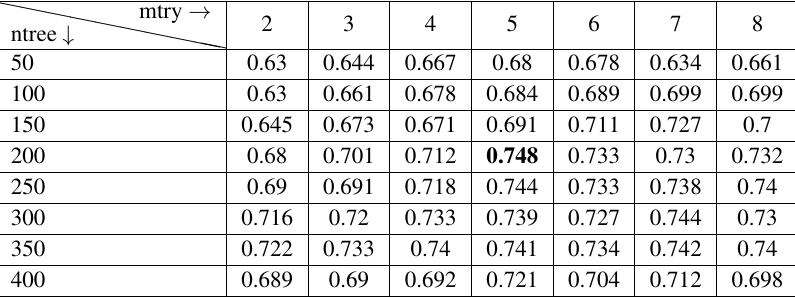
Table 2. Performance of RFR in terms of R 2